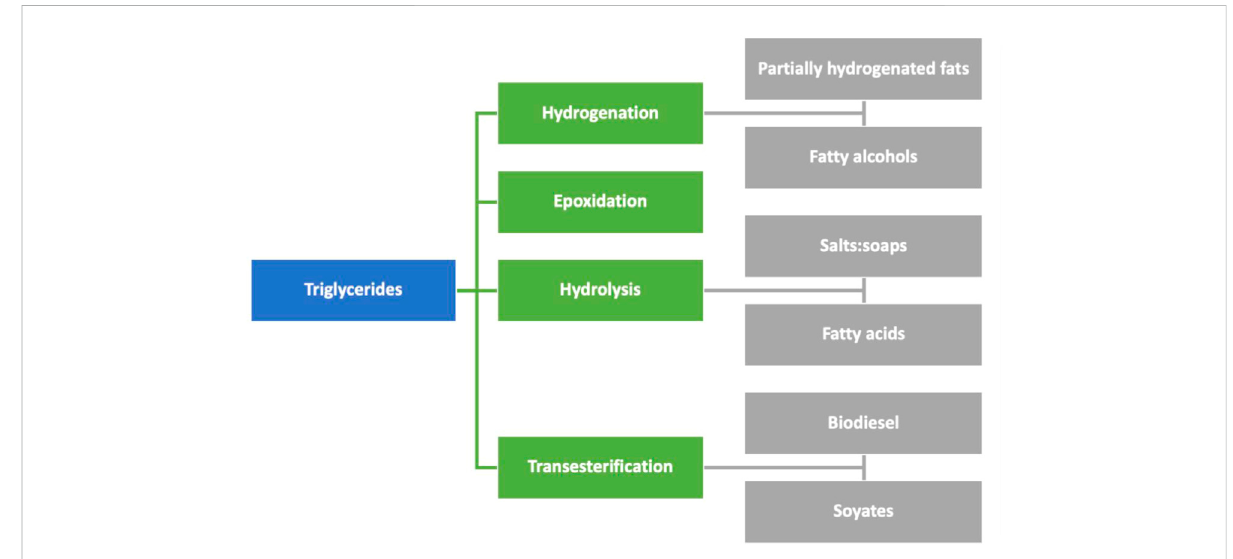
FIGURE 4 Schematic classi fi cation of the main triglycerides ’ transformations (in green) and the main derivatives obtained (in